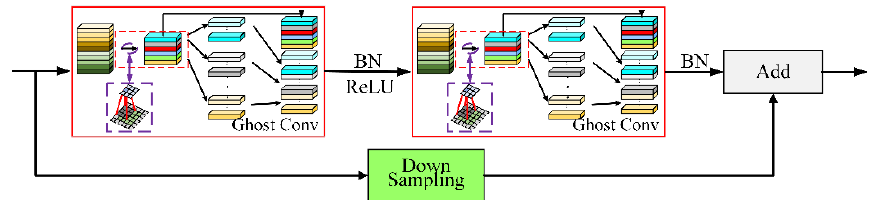
Figure 3. Ghost Bottleneck modules.